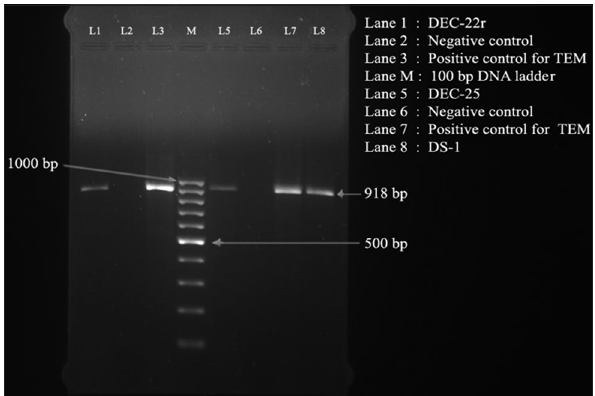
Figure-1: Polymerase chain reaction assay for detection of